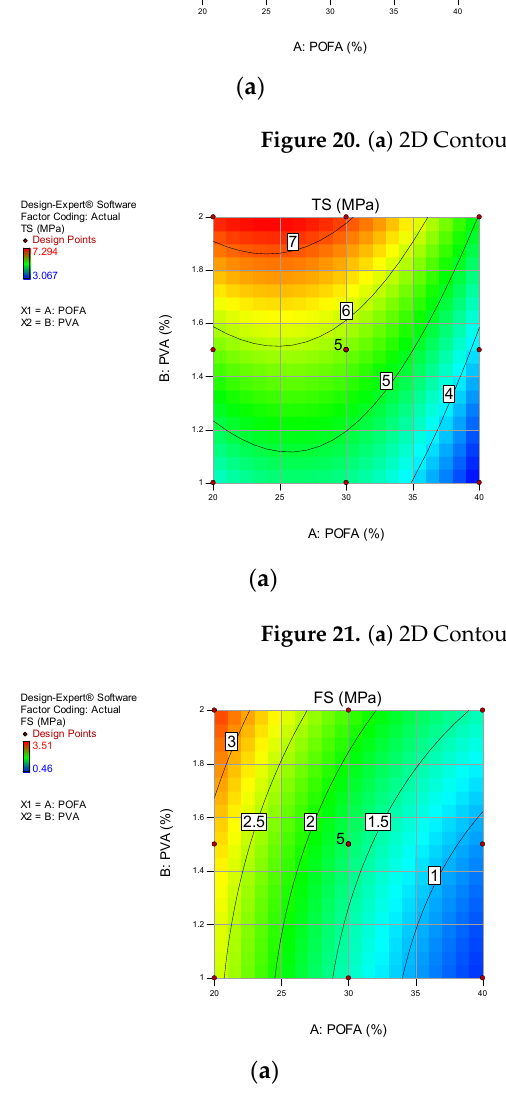
Figure 22 . ( a ) 2D Contour Plot and ( b ) 3D Response Surface Diagram for Flexural Strength.